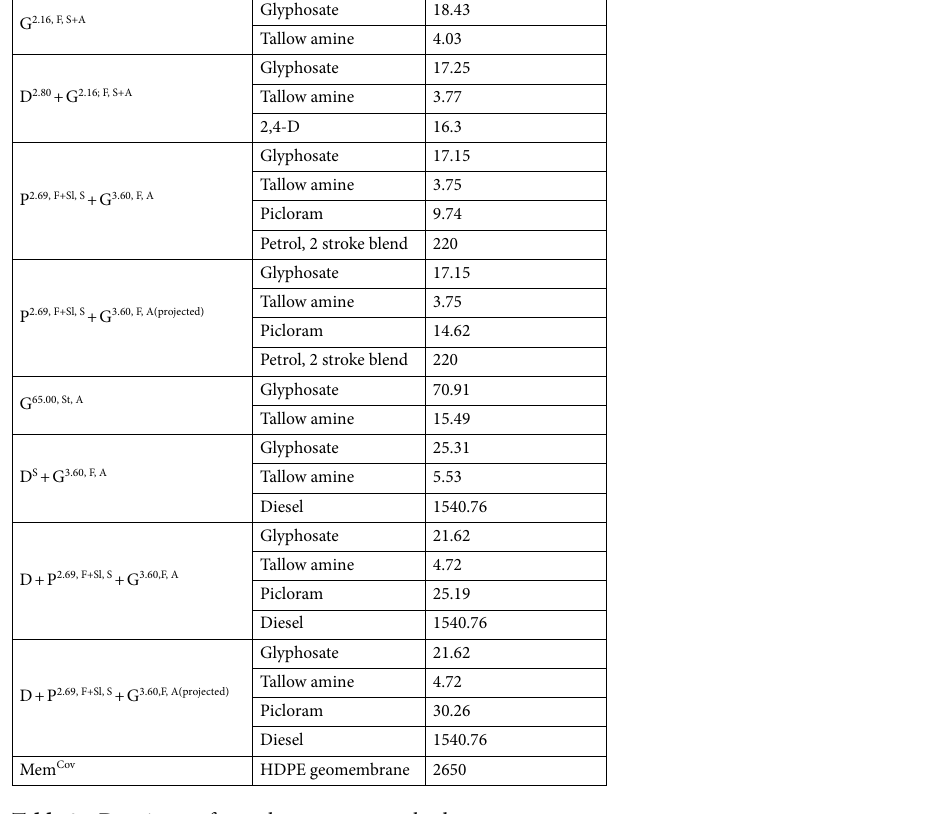
Table 2. Data inputs for each treatment